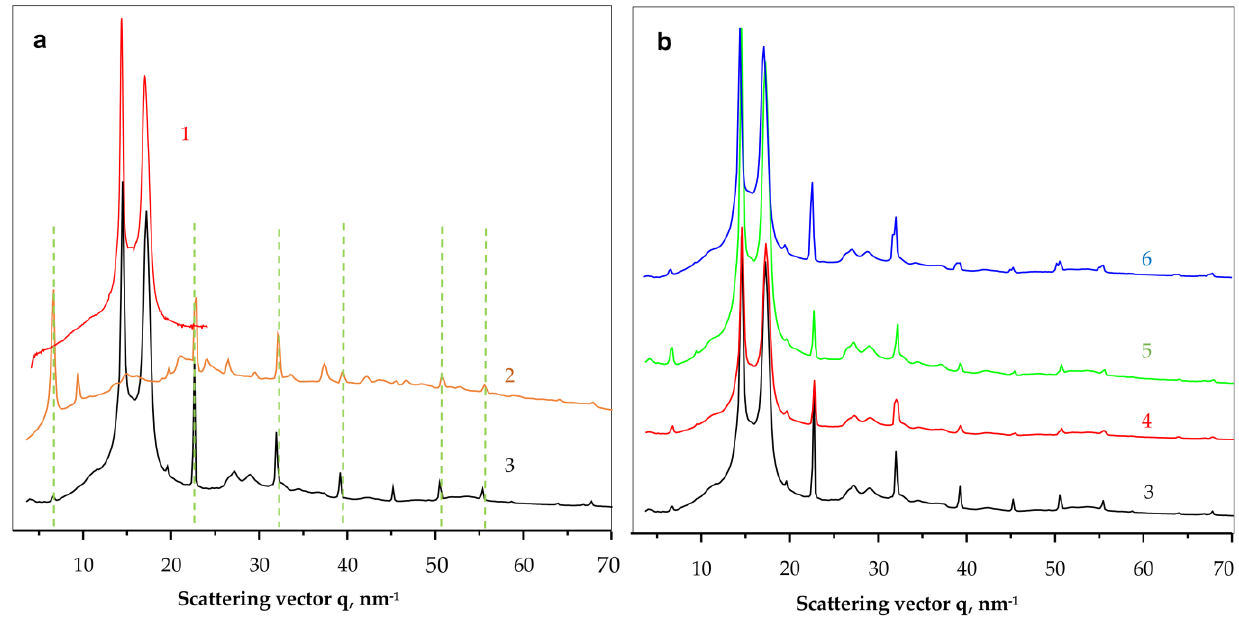
Figure 6. Comparative synchrotron WAXS patterns of NF and PANF. ( a ) — identification of the PA6 and NF building blocks; ( b ) — comparison of the scattering patterns of all PANF samples. 1 — PA6 MP; 2 — NF GH; 3 — NF GH/PA; 4 — NF GH&PA; 5 — NF G&PAiH; 6 — NF G/PAiH. The dahesd lines in Figure 6a relate the coinciding phospahe peaks in curves 2 and 3.